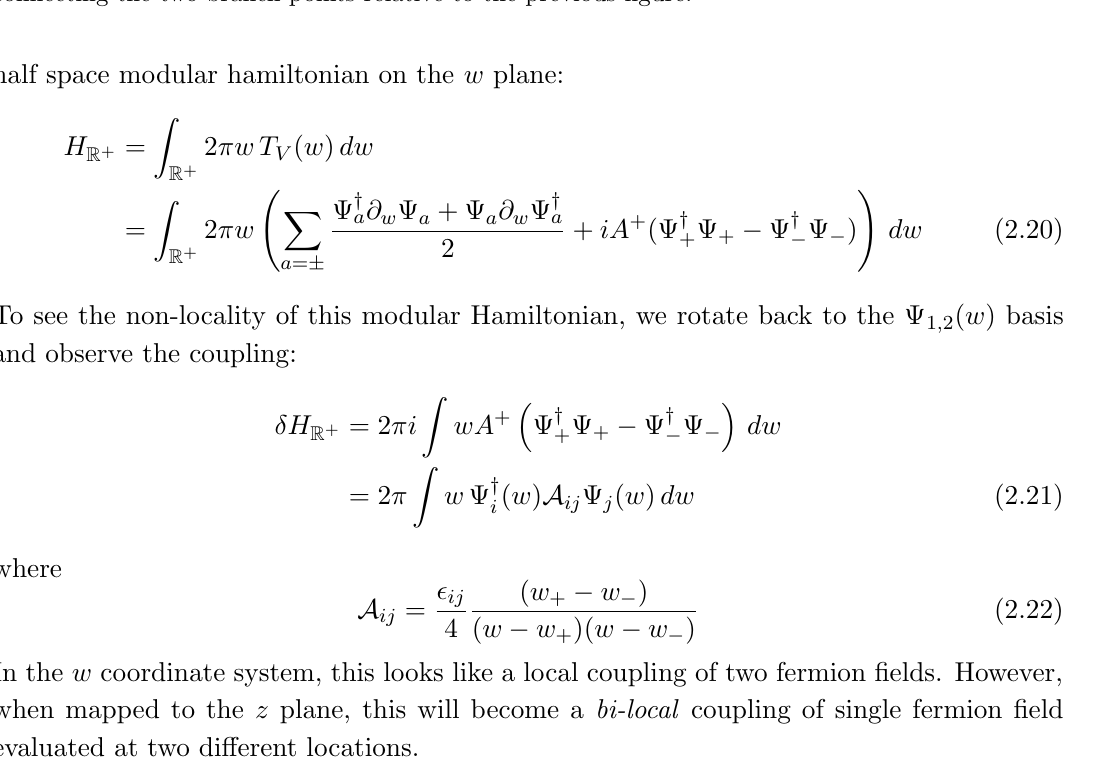
Figure 4 . The description of the two-interval reduced density matrix in equation (2.4) is manifest in the w coordinates, where the cutting and re-gluing of the region V under the modular (cid:13)ow is implemented by the branch points of the two-sheeted surface (cid:6). The (cid:12)gures are snap shots of the modular (cid:13)ow and moves in order from left, right to bottom. For clarity, we have deformed the cut connecting the two branch points relative to the previous